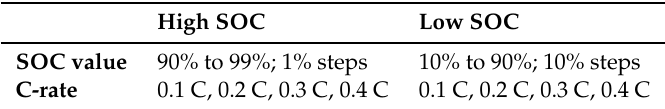
Table 2. Experimental setting for Coulombic efficiency measurement for VRLA battery.